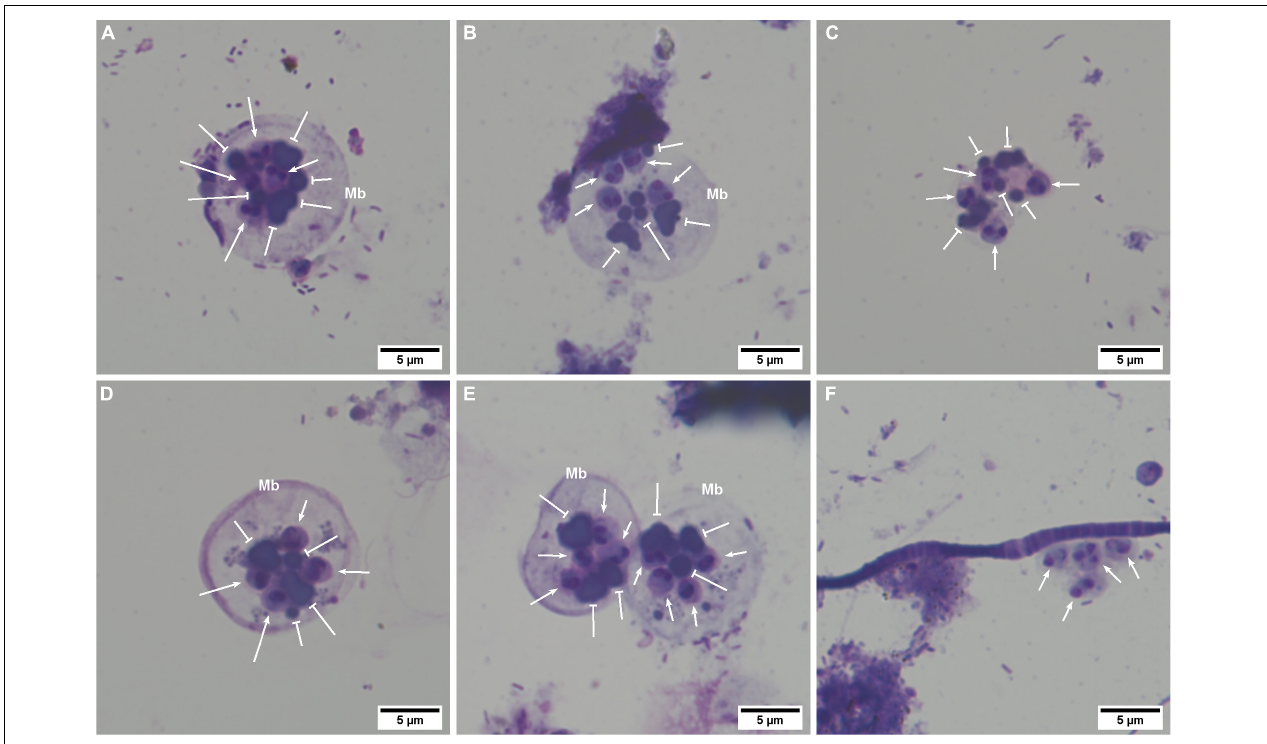
FIGURE 3 | Marteilia refringens cells observed by light microscopy on seawater and faeces cytocentrifugations (Hémacolor R (cid:13) stained). (A) “Type-1 cell” containing at least four spores (notched-head arrow) and five refringent bodies (bar-head arrow). (B) “Type-2 cell” with a less visible membrane (Mb) than in type-1 containing at least four spores and six refringent bodies. (C) “Type-3 cell” with no visible cell membrane and showing at least four spores and four visible refringent bodies. (D) Thick membrane observed sometimes in type-1 cells. (E) Agglomerated secondary-cells. (F) Free spores non-associated with refringent